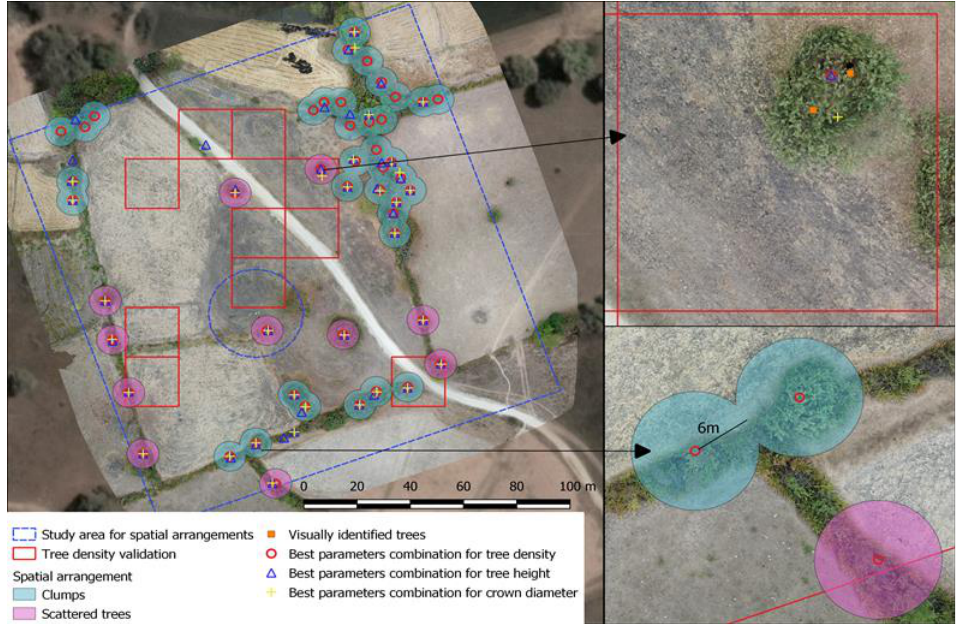
Figure 4. Tree density and spatial-arrangement assessment (left). Individual tree detection from visual observation and model estimation (upper right square); spatial-arrangement assessment (lower right square).